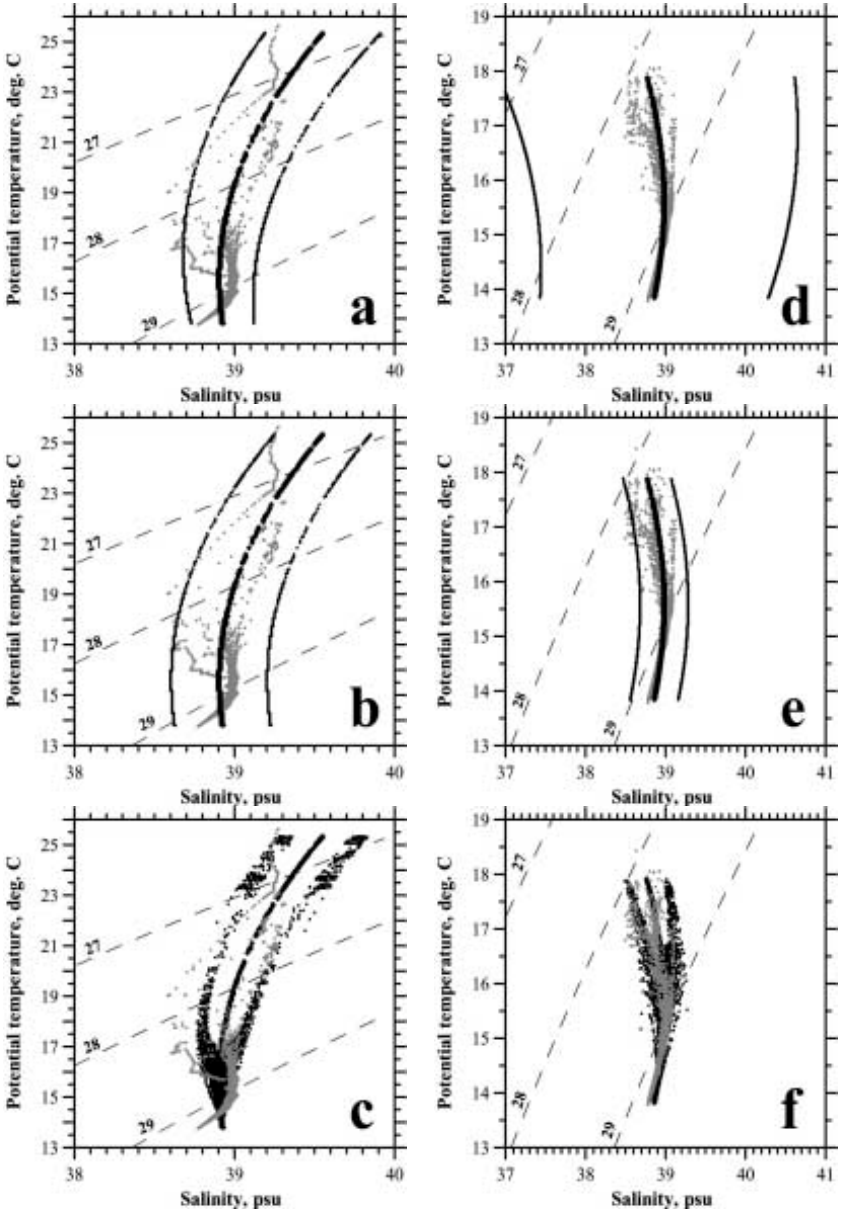
Fig. 6. The mean polynomial fit (thick black points), along with the mini- mum and maximum estimates (thin black points) as computed for the Oc- tober 1999 (a) and April 2000 (d) POSEIDON model runs. Overlaid in gray points are the available MEDAT- LAS data from the region. The mean fits with a δS = ± 0 . 3psu are pre- sented in (b) and (e) for October and April, respectively. The fits with δS = ± 0 . 3exp ( − z/ 100 m) are shown in (c) and (f) for October and April, respec-